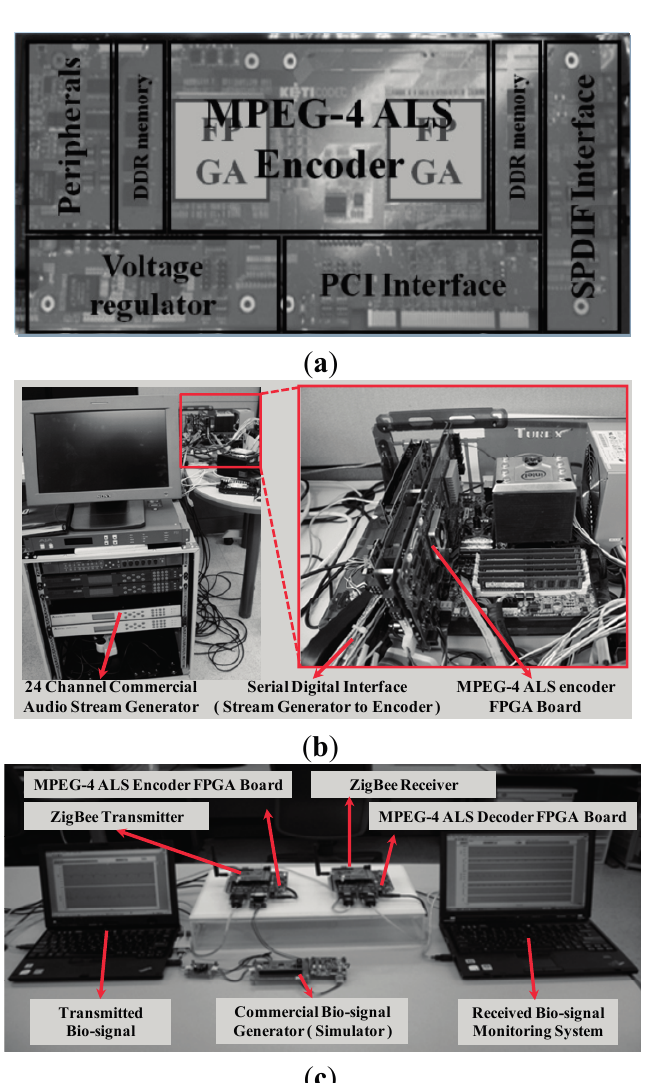
Figure 9. Implemented prototype system: ( a ) real-time multichannel MPEG-4 ALS encoder FPGA board; ( b ) prototype for multichannel audio system and ( c ) a prototype of bio-signal monitoring